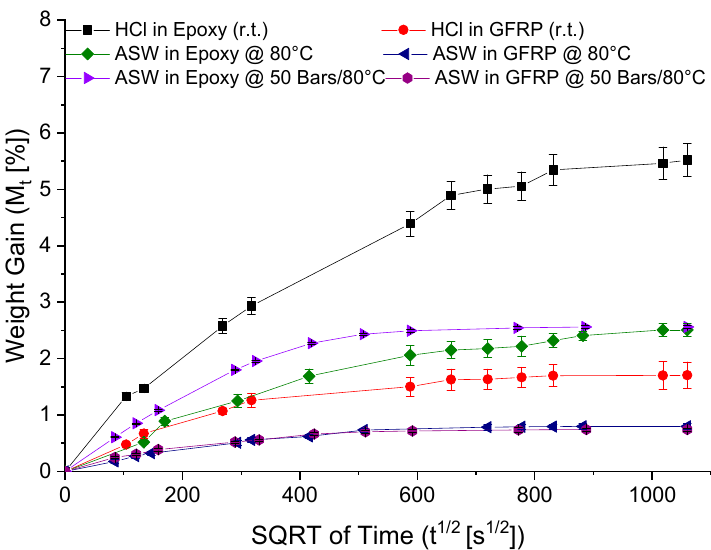
Figure 4. Weight increment of the epoxy and GFRP samples immersed in artificial sea water (ASW) at 80 °C, 80 °C under 50 bars of pressure and in HCl at room temperature.